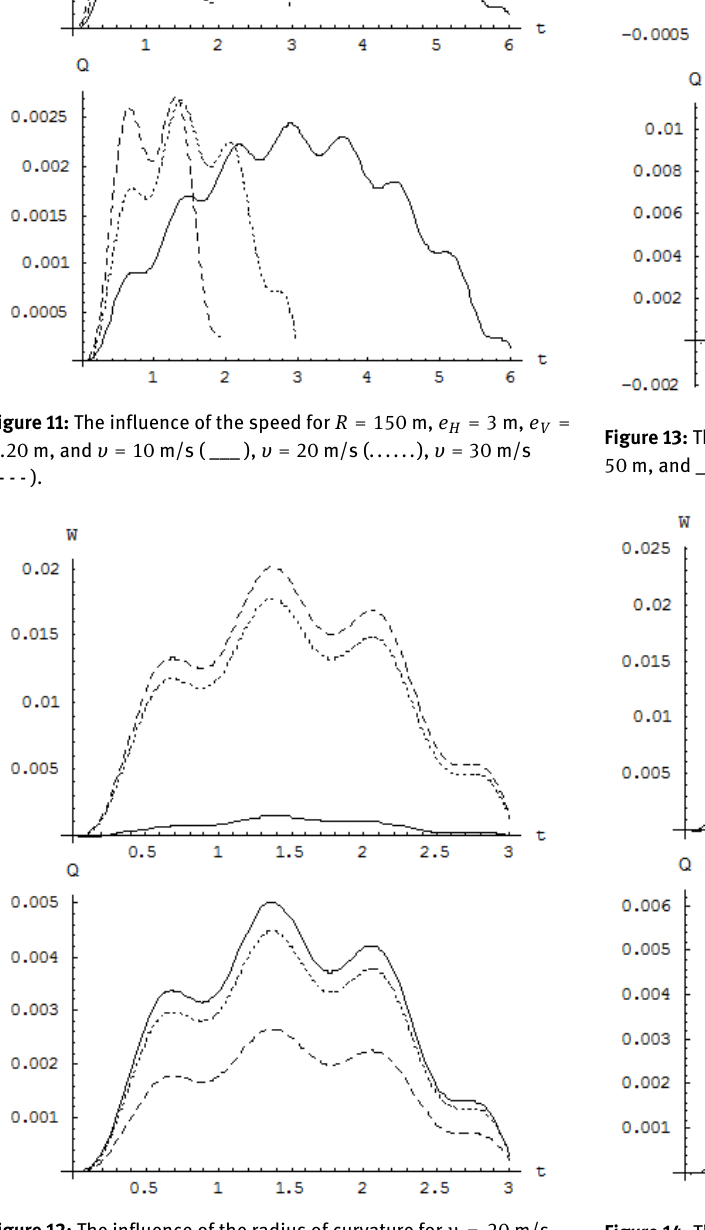
Figure 14: The influence of the eccentricity for υ = 30 m/s, R = 100 m, and ___ e H = 3 m, ...... e H = 0 m, - - - e H = −3